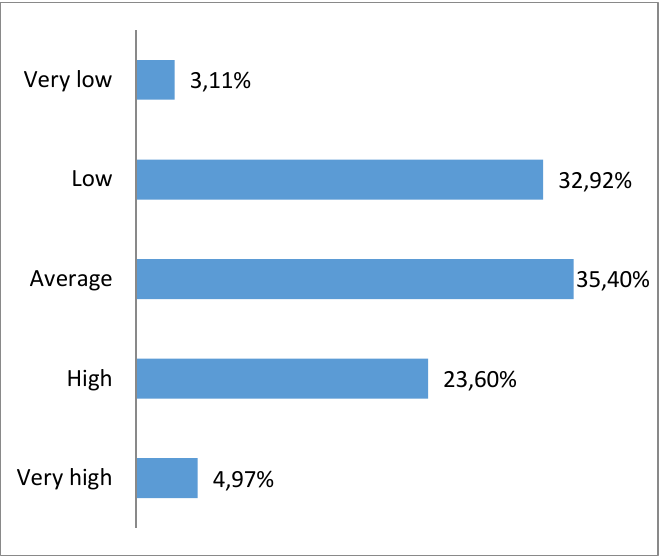
Figure 3: Level of adoption of lean concept on construction projects.